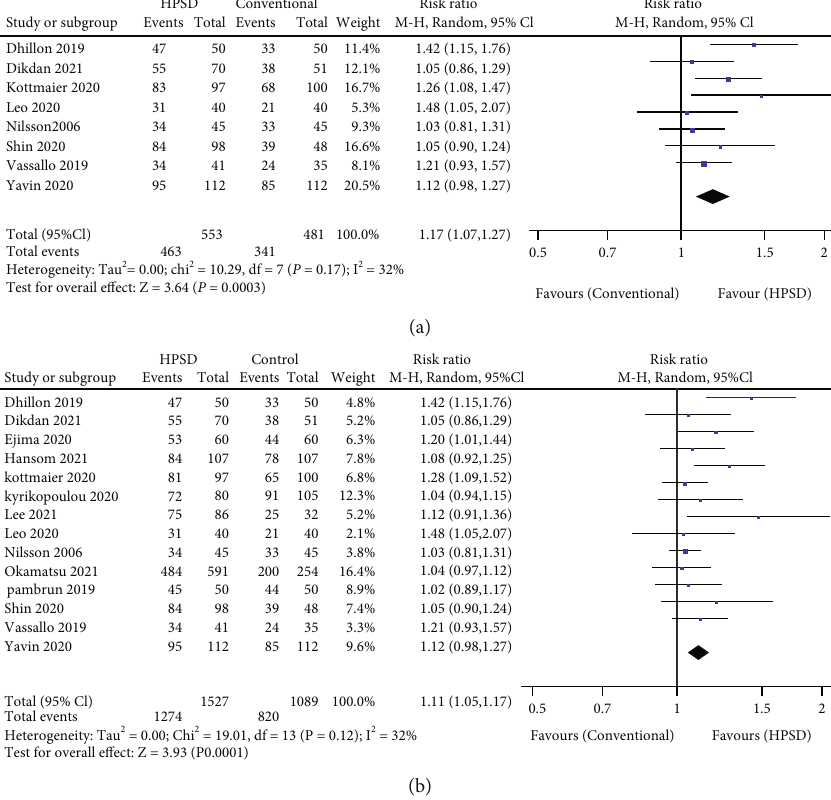
Figure 3: Forest plot of pooled e ff ect demonstrating (a) free from atrial fi brillation (AF) for 12 months and (b) free from atrial tachyarrhythmia (AT) for 12 months in high-power short-duration (HPSD) and conventional ablation settings. 95% CI: 95% con fi dence